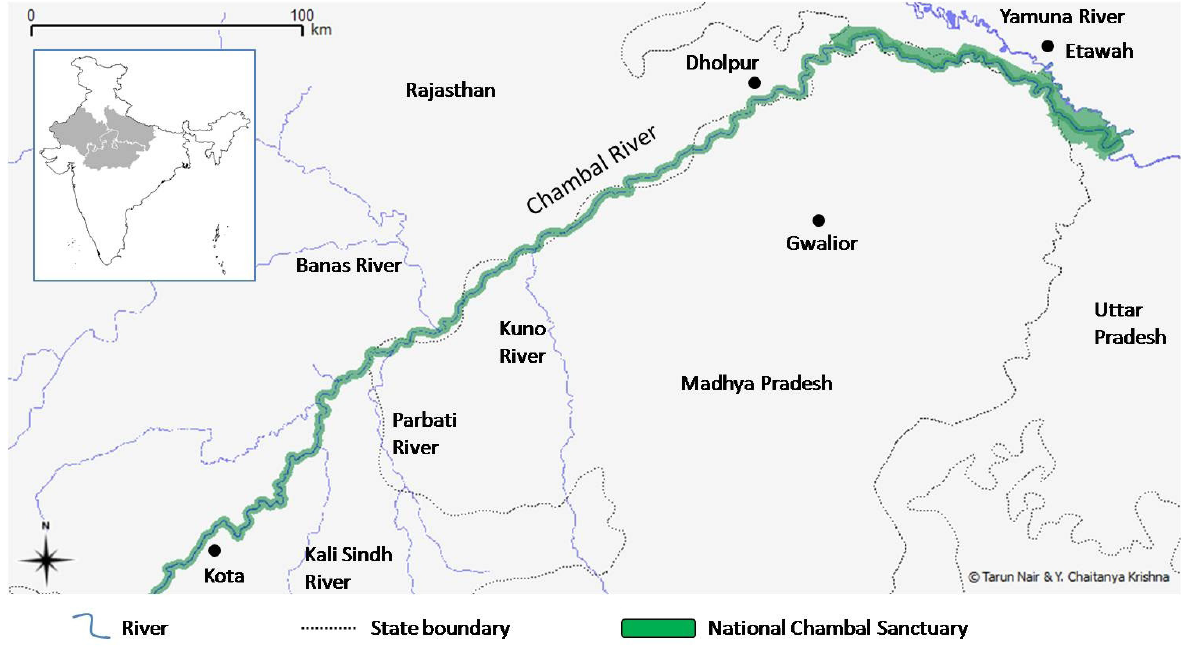
Figure 1. location of the study area (Inset) across the states of Rajasthan, Madhya Pradesh and uttar Pradesh; and map of the National Chambal Sanctuary, covering an area of approximately 1800km 2